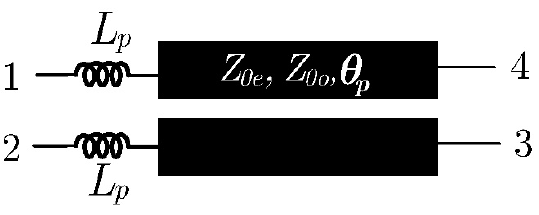
Figure 1. A sketch of the ICPCL.